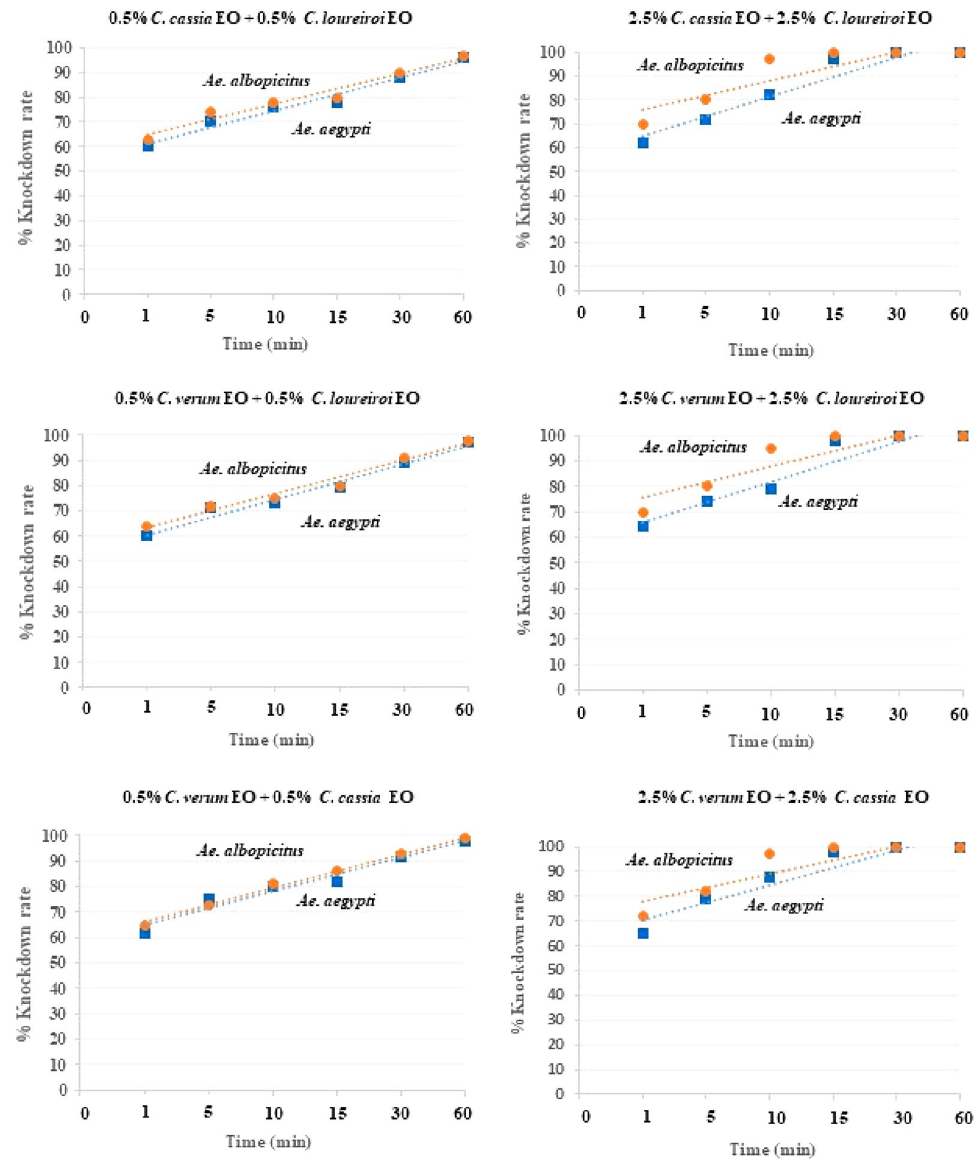
Figure 2. Linear regression between % knockdown rate and exposure time (min) of combinations of EOs against females of Ae . aegypti and Ae . albopictus